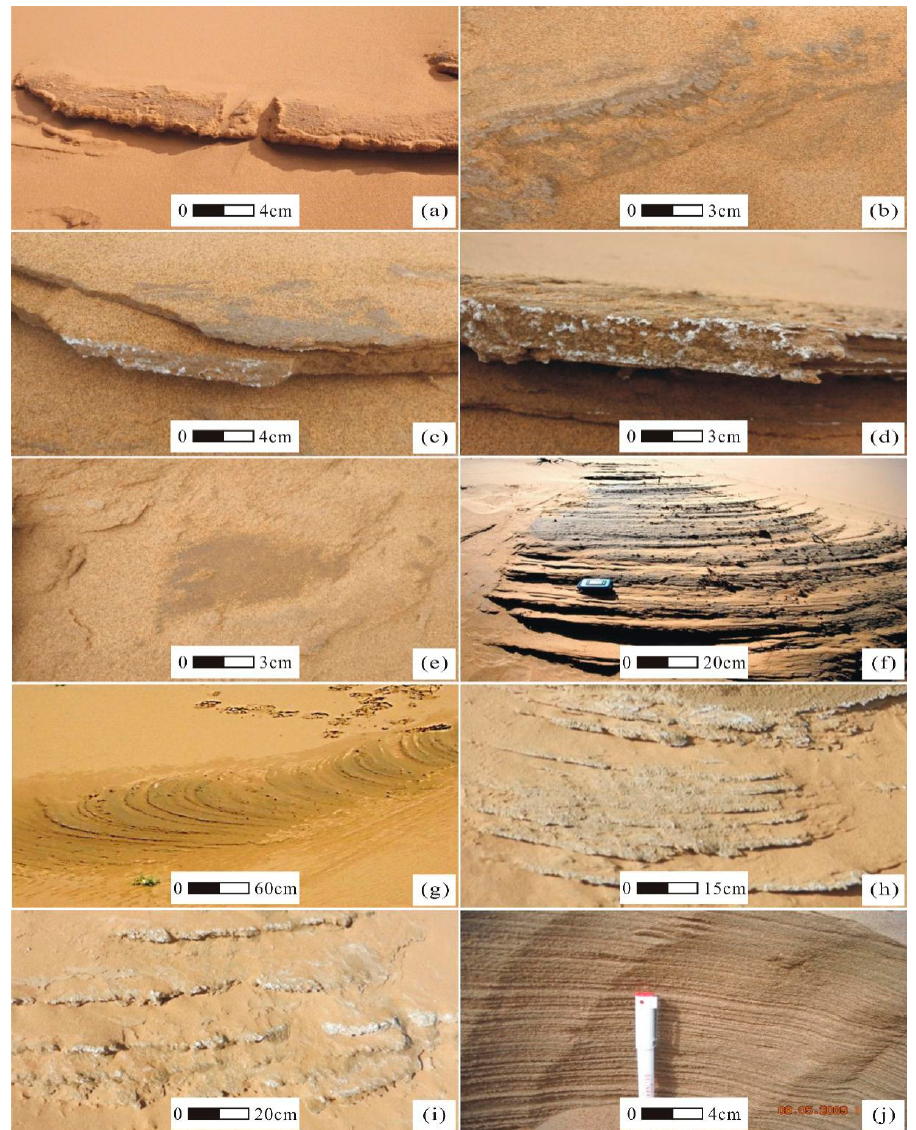
Figure 2. Microtopography on the slopes of the Badain Jaran megadunes. ( a , b ). Curved step with a dark surface in the upper part of the windward slope of the megadune to the east of Zhalate Lake. ( c , d ). Curved step with white precipitated CaCO 3 in the central part of the leeward slope of the megadune to the west of Yinderritu Lake. ( e ). Erosional runo ff depression in the upper part of the windward slope of the megadune in the east of Zhalate Lake; note the dark base. ( f ). Multi-stage fan in the central part of the windward slope of the megadune to the east of Nuoertu Lake; note the dark surface. ( g ). Multi-stage fan in the upper part of the windward slope of the megadune to the east of Zhalate Lake; note the moist surface. ( h , i ). Multi-stage fan in the central part of the leeward slope of